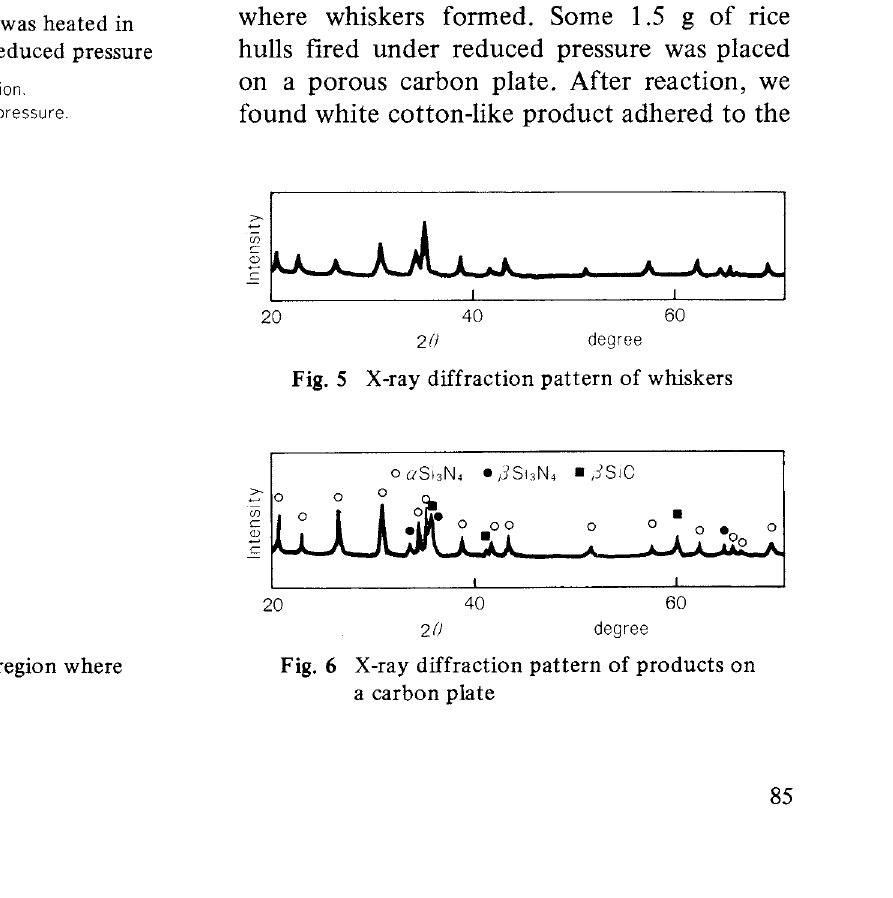
Fig. 3 IR spectra of rice hulls which was heated in 1 N HN0 3 solution or under reduced pressure A: Heat treatment in INHNO, solution. B : Heat treatment under reduced pressure.